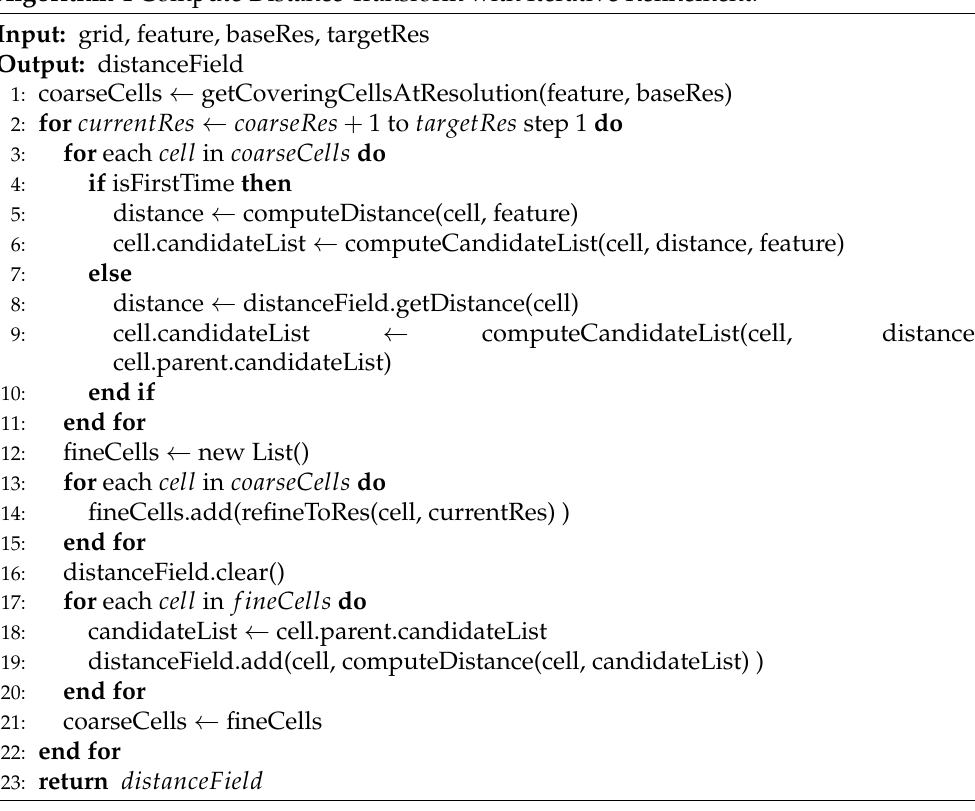
Algorithm 4 Compute Distance Transform with Iterative